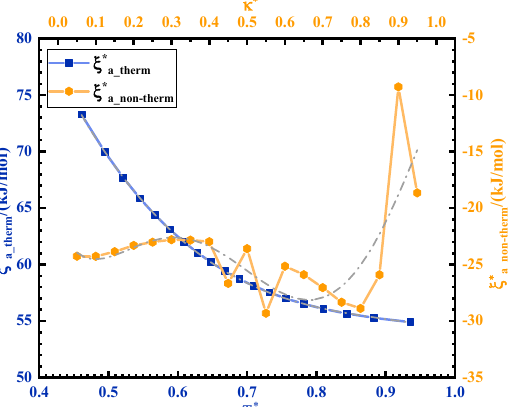
Figure 5. Variation in the activation energy corresponding to thermal and non-thermal effects in ultrasonic curing.